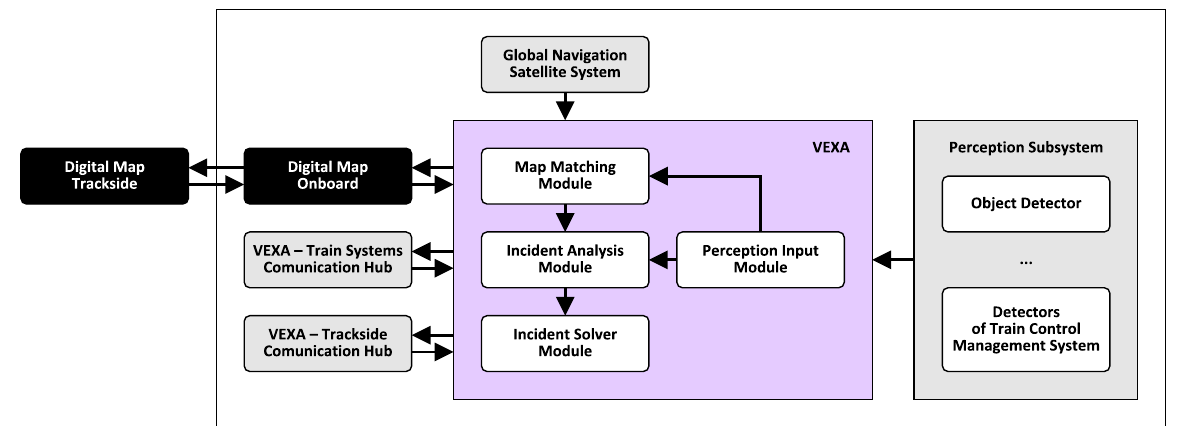
Figure 1. Logical architecture of the VEXA system